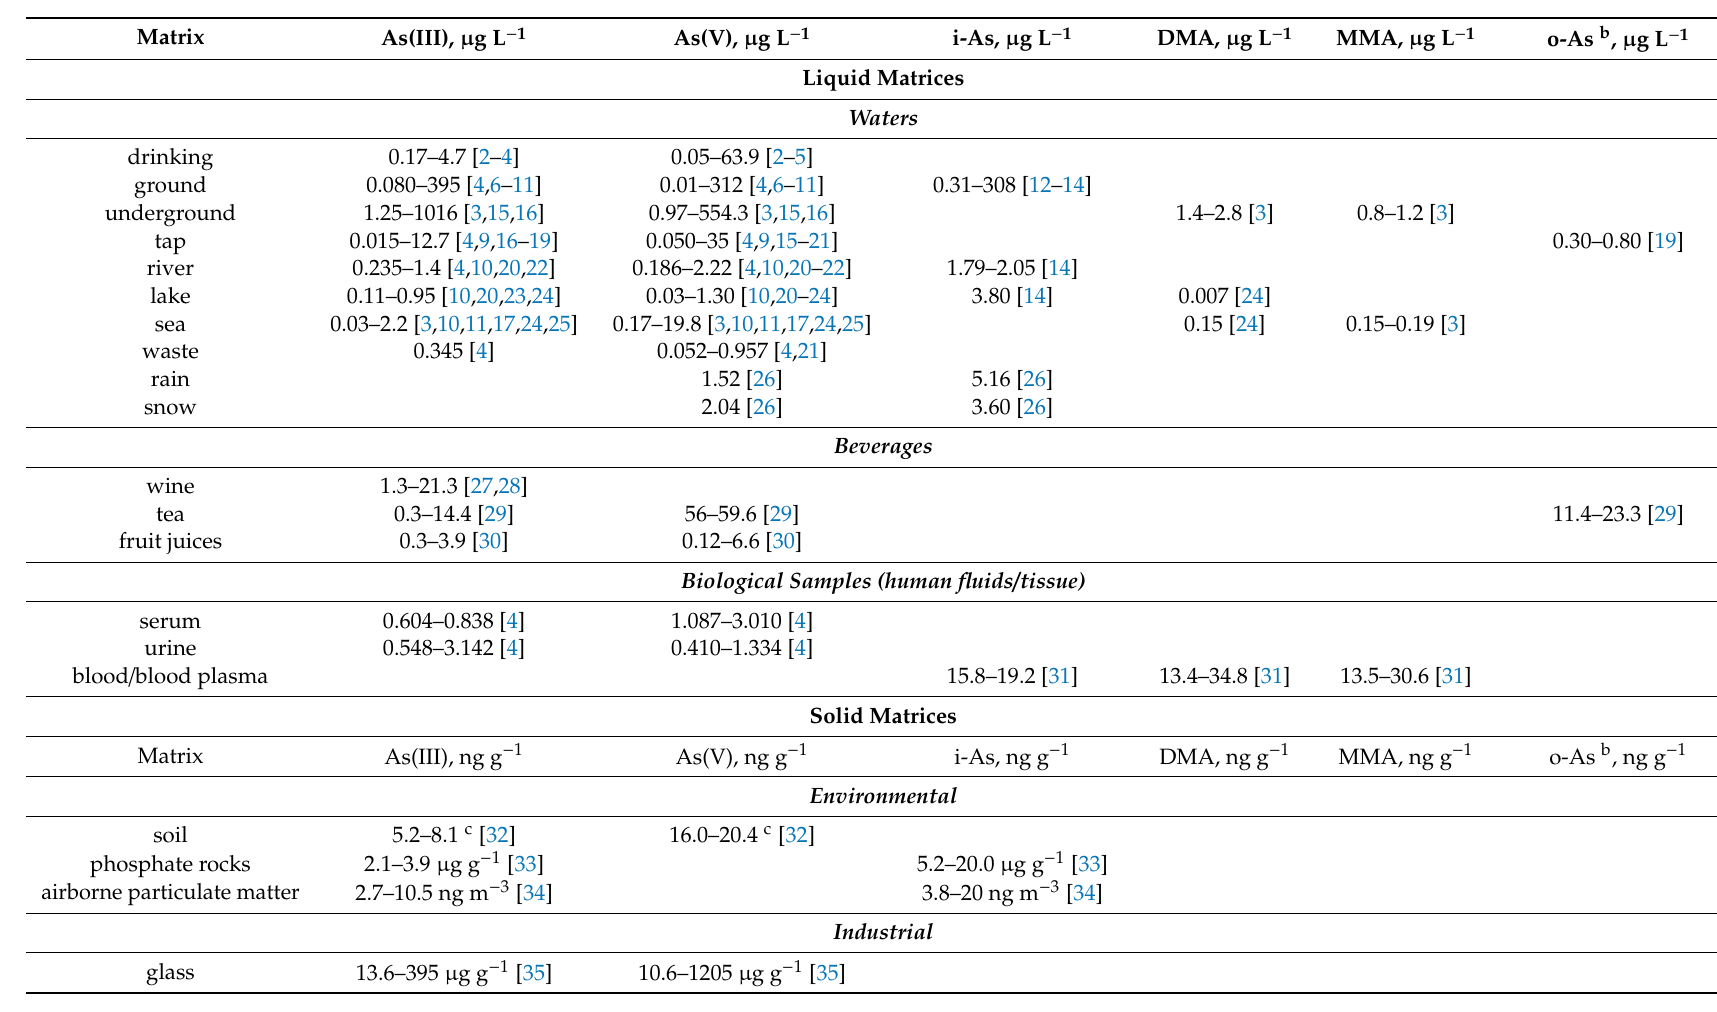
Table 1. The concentrations of As species in di ff erent samples obtained by non-chromatographic methods based on the hydride generation technique a